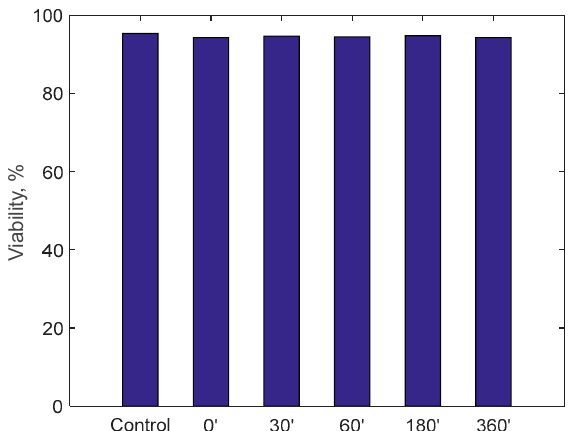
Figure 13. Viability on monocytes cell line U937 after incubation with fluid circulated in the RAP for up to 360 minutes.